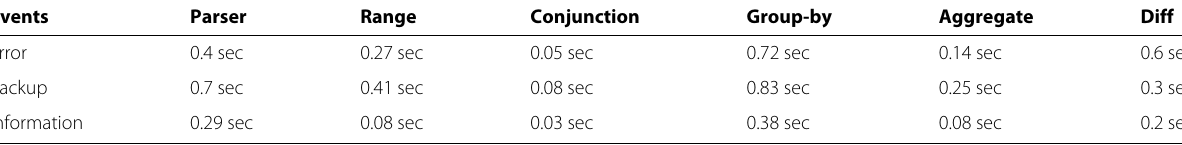
Table 6 Heterogeneous stream join through Diff operator Events Parser Range Conjunction Group-by Aggregate Diff Error 0.4 sec 0.27 sec 0.05 sec 0.72 sec 0.14 sec 0.6 sec Backup 0.7 sec 0.41 sec 0.08 sec 0.83 sec 0.25 sec 0.3 sec Information 0.29 sec 0.08 sec